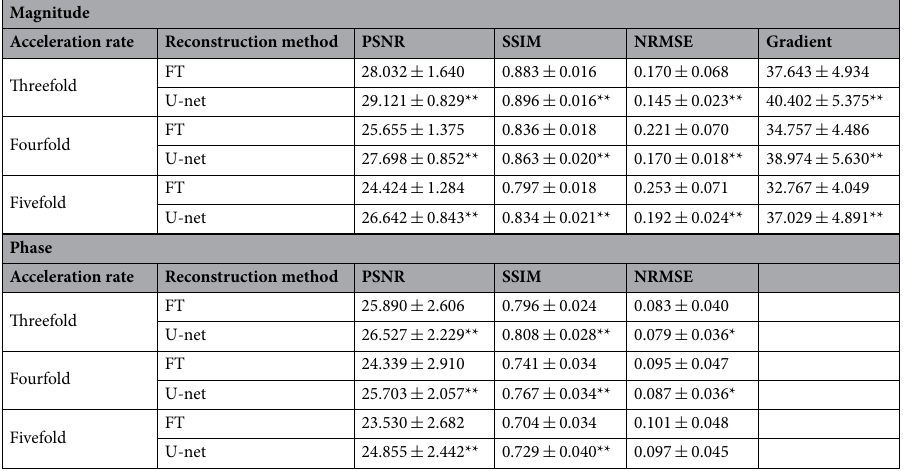
Table 1. Summary of performance obtained on the magnitude and phase images for different acceleration rates. The stars indicate when differences in metrics between U-net and FT are statistically significant (* for p < 0.01667; ** for p << 0.001; the comparison not showing statistical significance had p-value = 0.073 for the phase image).